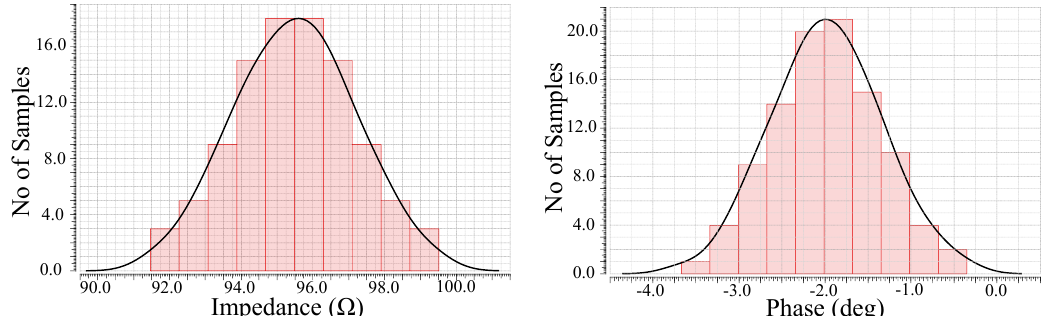
Figure 34. Sensitivity performance of magnitude for target impedance R b = 100 Ω using Monte-Carlo analysis (IFLF design).